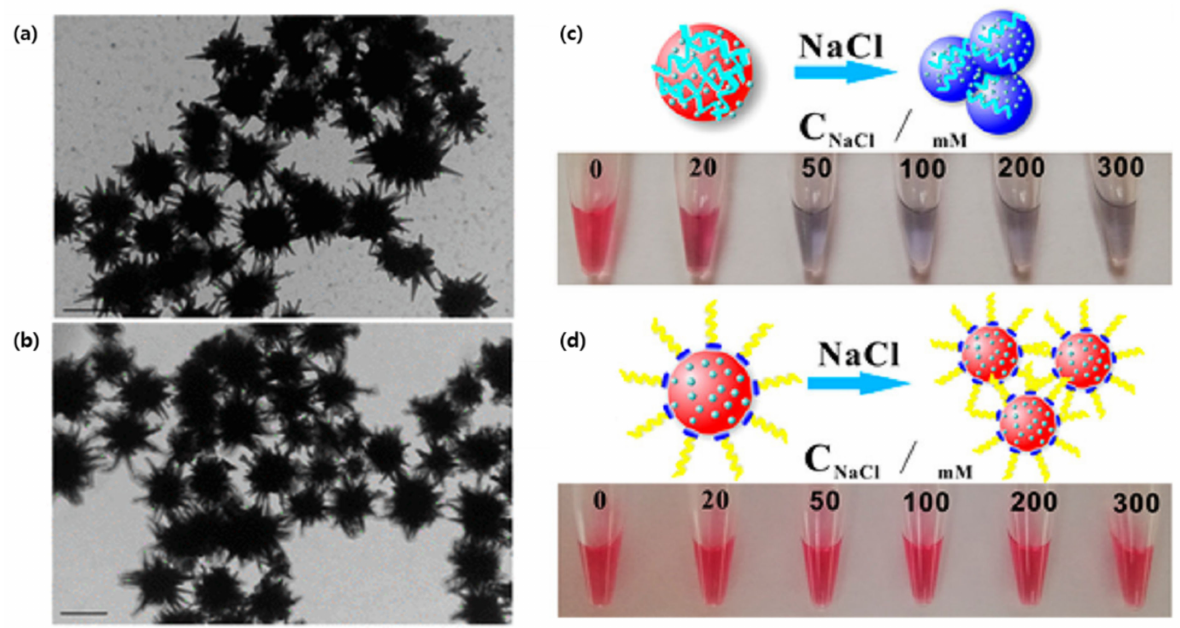
Figure 3. Gold nanoparticles aptamer binding: ( a ) TEM of synthesized gold nanostars and ( b ) 4- aminothiophenol and EpCAM aptamer-functionalized gold nanostars. (Scale bars are 100 nm) ( c ) Photo of the ionic strength-dependent color change of the non-polyA-Tau apt/DTNB/AuNPs. ( d ) Photo of the ionic strength-dependent color change of the polyA-Tau apt/DTNB/AuNPs. (Repro- duced with permission from [77], published by American Chemical Society 2018; reproduced with permission from [79], published by American Chemical Society